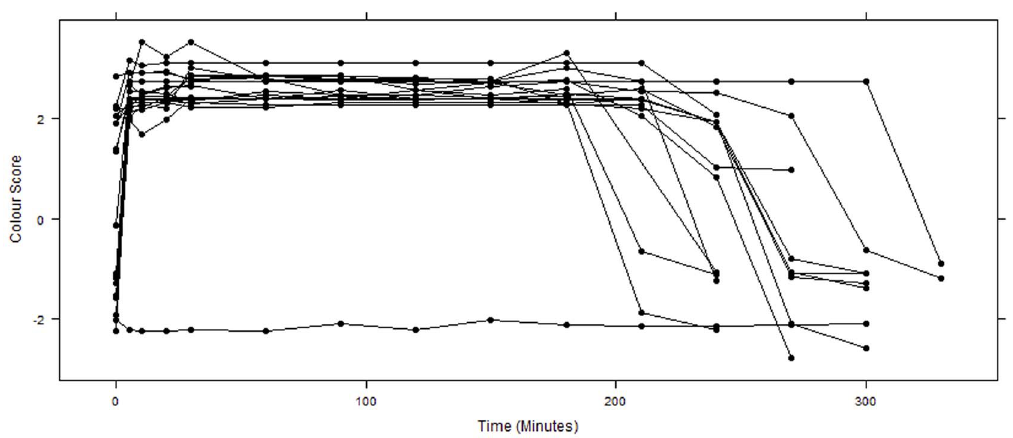
Figure 2. L. wilcoxii male dorsal colour change during amplexus (n 5 19). Points indicate colour of each individual male, colour changes over time (0– 300 minutes). Colour score of a single female throughout amplexus is provided as a reference (lower line where now increase is observed). There was a significant difference in colour between baseline and all tested time points (p 5 0.0001) until 240 minutes (p 5 0.2920). From time 270 to 330, scores were significantly lower than baseline (p 5